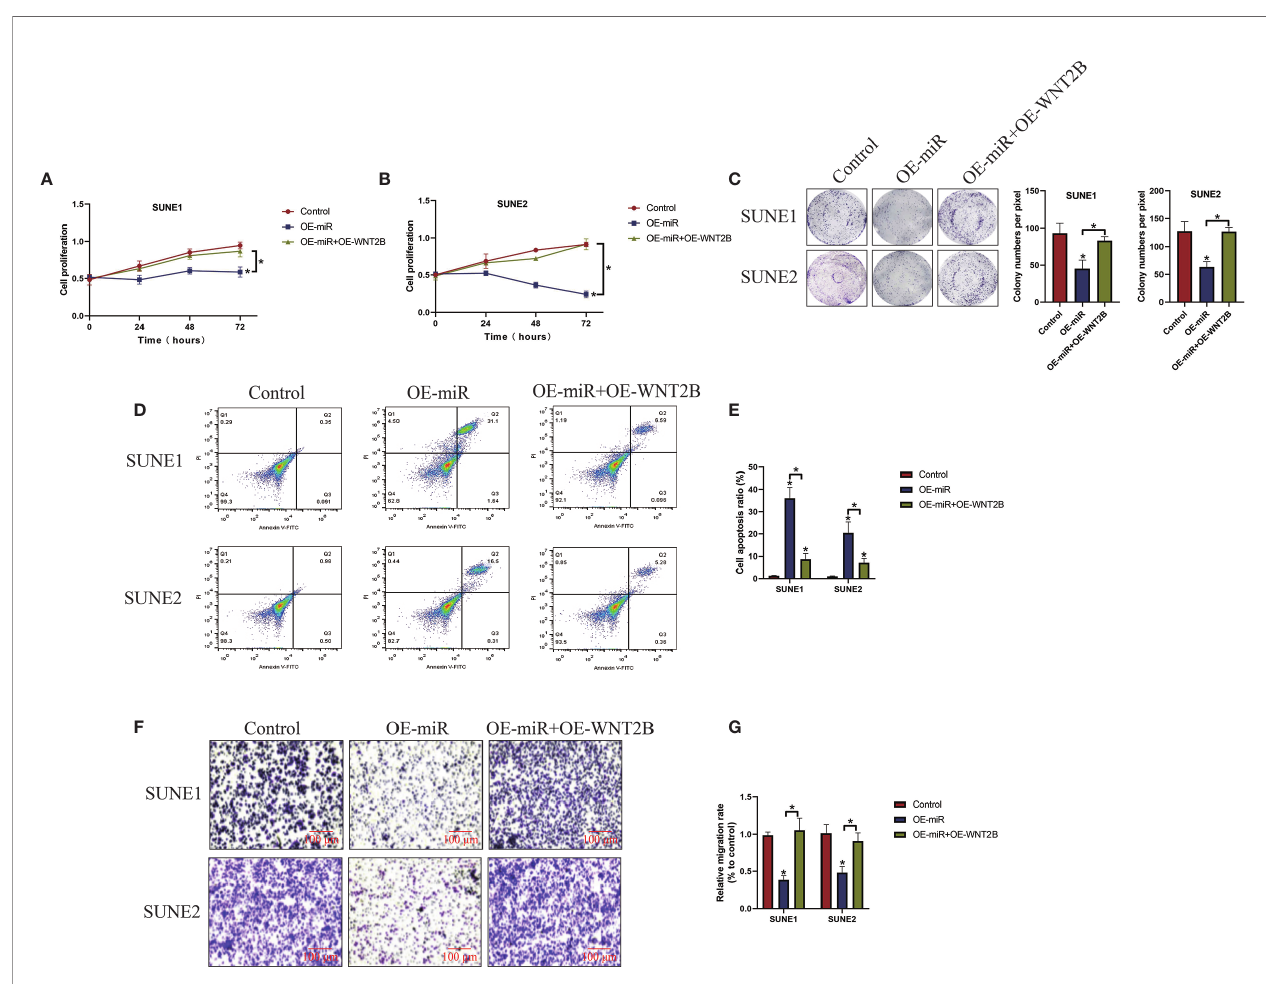
FIGURE 5 | Overexpression of microRNA-338-5p inhibited cancer progression in NPC by inhibiting WNT2B. The NPC cells were transfected with microRNA-338-5p mimic and WNTB overexpression vectors, respectively. (A, B) CCK-8 assay was used to examine cell proliferation abilities. (C) Colony formation assay was used to determine colonies formation abilities in NPC cells. (D, E) Annexin V-FITC/PI double staining assay was performed to measure cell apoptosis ratio. (F, G) Transwell assay was performed to examine cell migration abilities. Each experiment repeated at least three times, and * P <